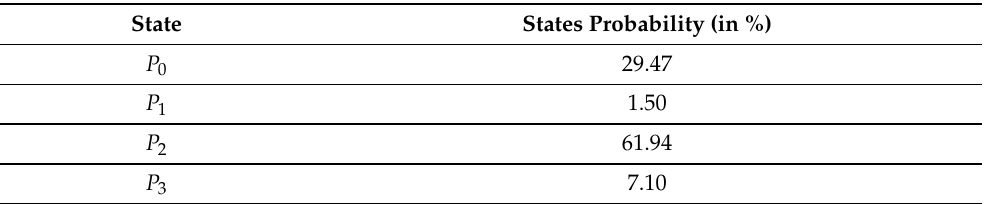
Table 4. Four-state probability model for floating production storage and offloading generator “C”—Scenario